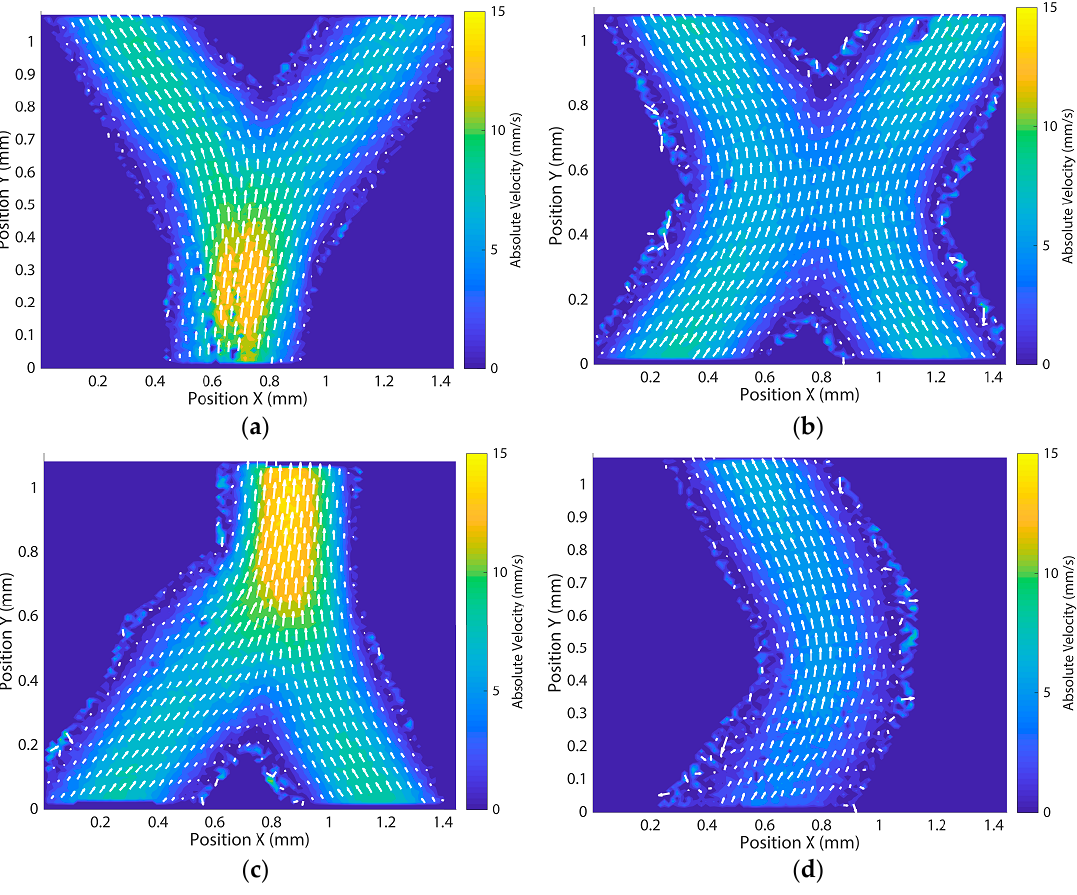
Figure A4. PIV measurement data for crossing network: ( a ) Flow field at inlet and first bifurcation; ( b ) Flow field at crossing; ( c ) Flow field at outlet and merging point; ( d ) Flow field at bend inside the network.